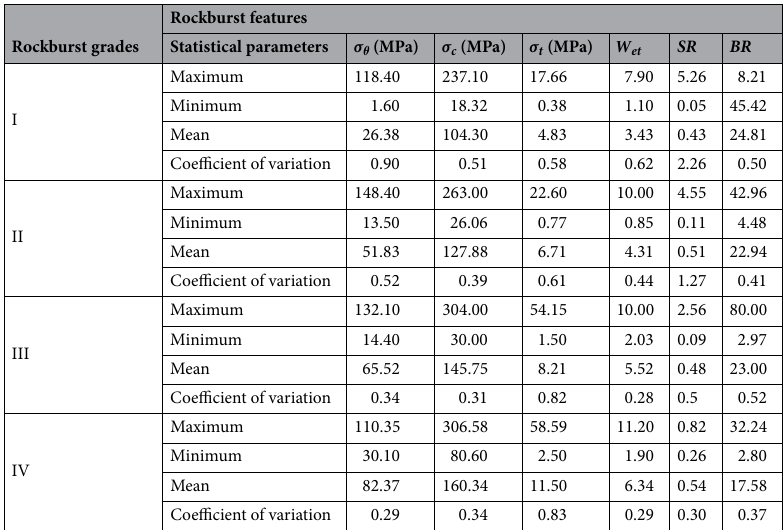
Table 1. Statistical parameters of different rockburst grades.